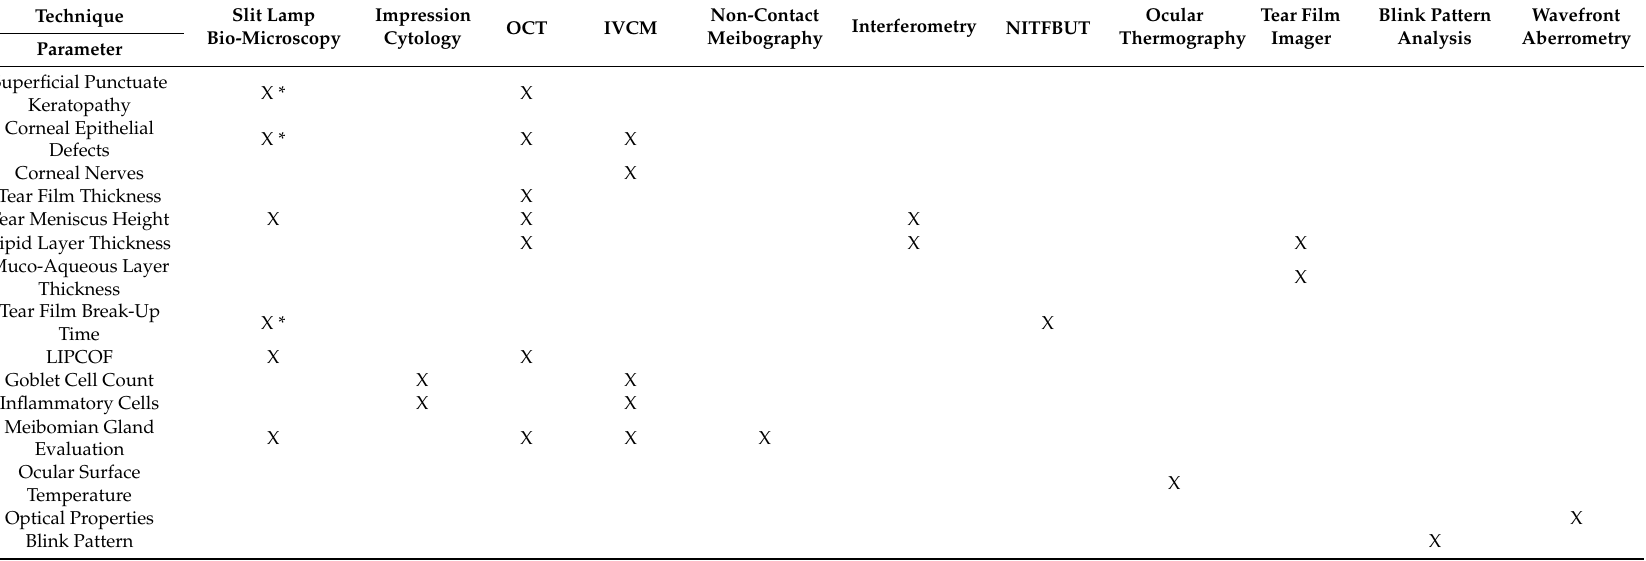
Table 1. The lines list the techniques that are covered in this review, the columns list the di ff erent parameters that can be assessed. LIPCOF = lid parallel conjunctival folds, OCT = Optical coherence tomography, IVCM = in vivo confocal microscopy, NITFBUT = non-invasive tear film break-up time. * requires instillation of